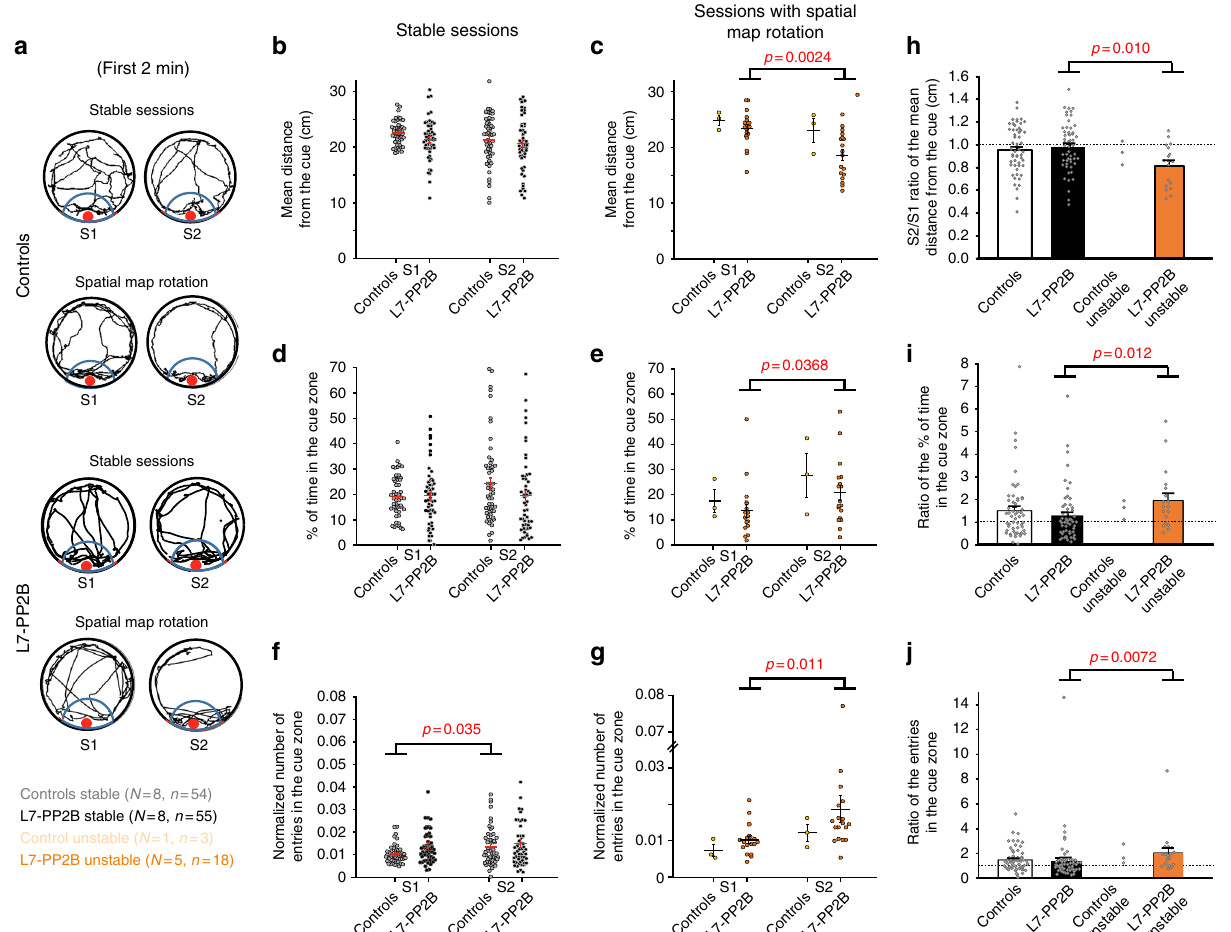
Fig. 2 Spatial map rotation is associated with increased cue exploration. a Examples of control and L7-PP2B mice running tracks during the fi rst 2 min of exploration in consecutives stable sessions, or in sessions associated with spatial map rotation (SSMR). b – g Scatterplot showing the mean distance from the cue ( b , c ), the % of time in the cue zone ( d , e ) and the number of entries in the cue zone, normalized by the traveled distance ( f , g ) in stable sessions and in SSMR. Basal characterization of cue behavior during the 1st session of stable sessions showed a tendency in L7-PP2B mice to explore more the object than controls (mean distance from the cue, U = 1681, p = 0.011; % of time spent in the cue zone, U = 2080, p = 0.44; normalized number of entries in the cue zone, U = 1349, p < 0.001). An increase in cue behavior was observed in L7-PP2B mice, in S2 relative to S1 during SSMR, but not during stable sessions (mean distance from the cue: stable sessions Z = 0.82, p = 0.82; SSMR, Z = 3.24, p = 0.0024; % of time in the cue zone: stable sessions Z = 0.20, p = 0.17; SSMR, Z = 2.37, p = 0.0368; normalized number of entries in the cue zone: stable sessions Z = 0.017, p = 1; SSMR, Z = 2.77, p = 0.011, Wilcoxon Signed-Rank test). h – j S2/S1 ratio of the mean distance from the cue ( h ), the percentage of time in the cue zone ( i ), and the normalized number of entries in the cue zone ( j ) in controls and L7-PP2B mice. In L7-PP2B mice, all parameters were modi fi ed in SSMR compared to stable sessions (mean distance from the cue, U = 275, p = 0.010; % of time in the cue zone, U = 281, p = 0.012; normalized number of entries in the cue zone, U = 267, p = 0.0072, Mann – Whitney U test). In control mice, no statistical comparison was applied given the low sample size of unstable cells. p values were adjusted for multiple comparisons with a Bonferroni correction. N and n indicate mice and cell number, respectively. Error bars represent